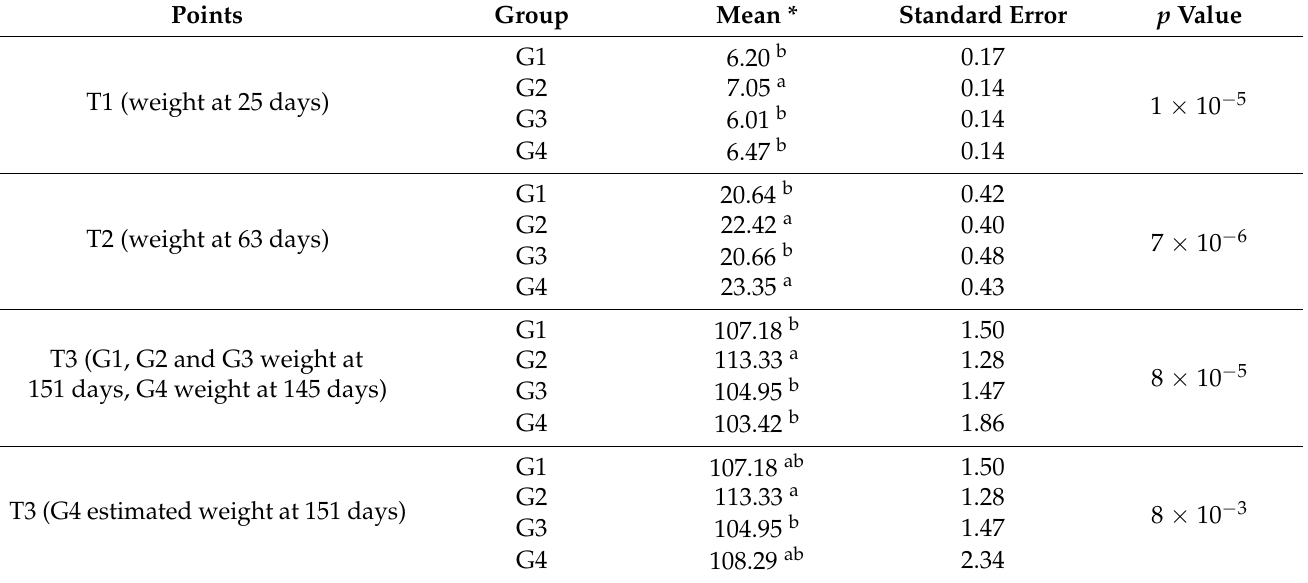
Table 2. Weight at weaning (T1), at the end of nursery (T2), and at slaughter time (T3) for the four different